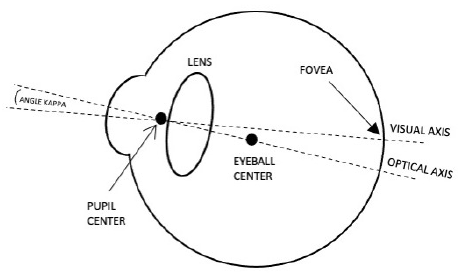
Figure 1. Human eye visual axes. Both visual and optical axes pass through the pupil center. Only the optical axis can be